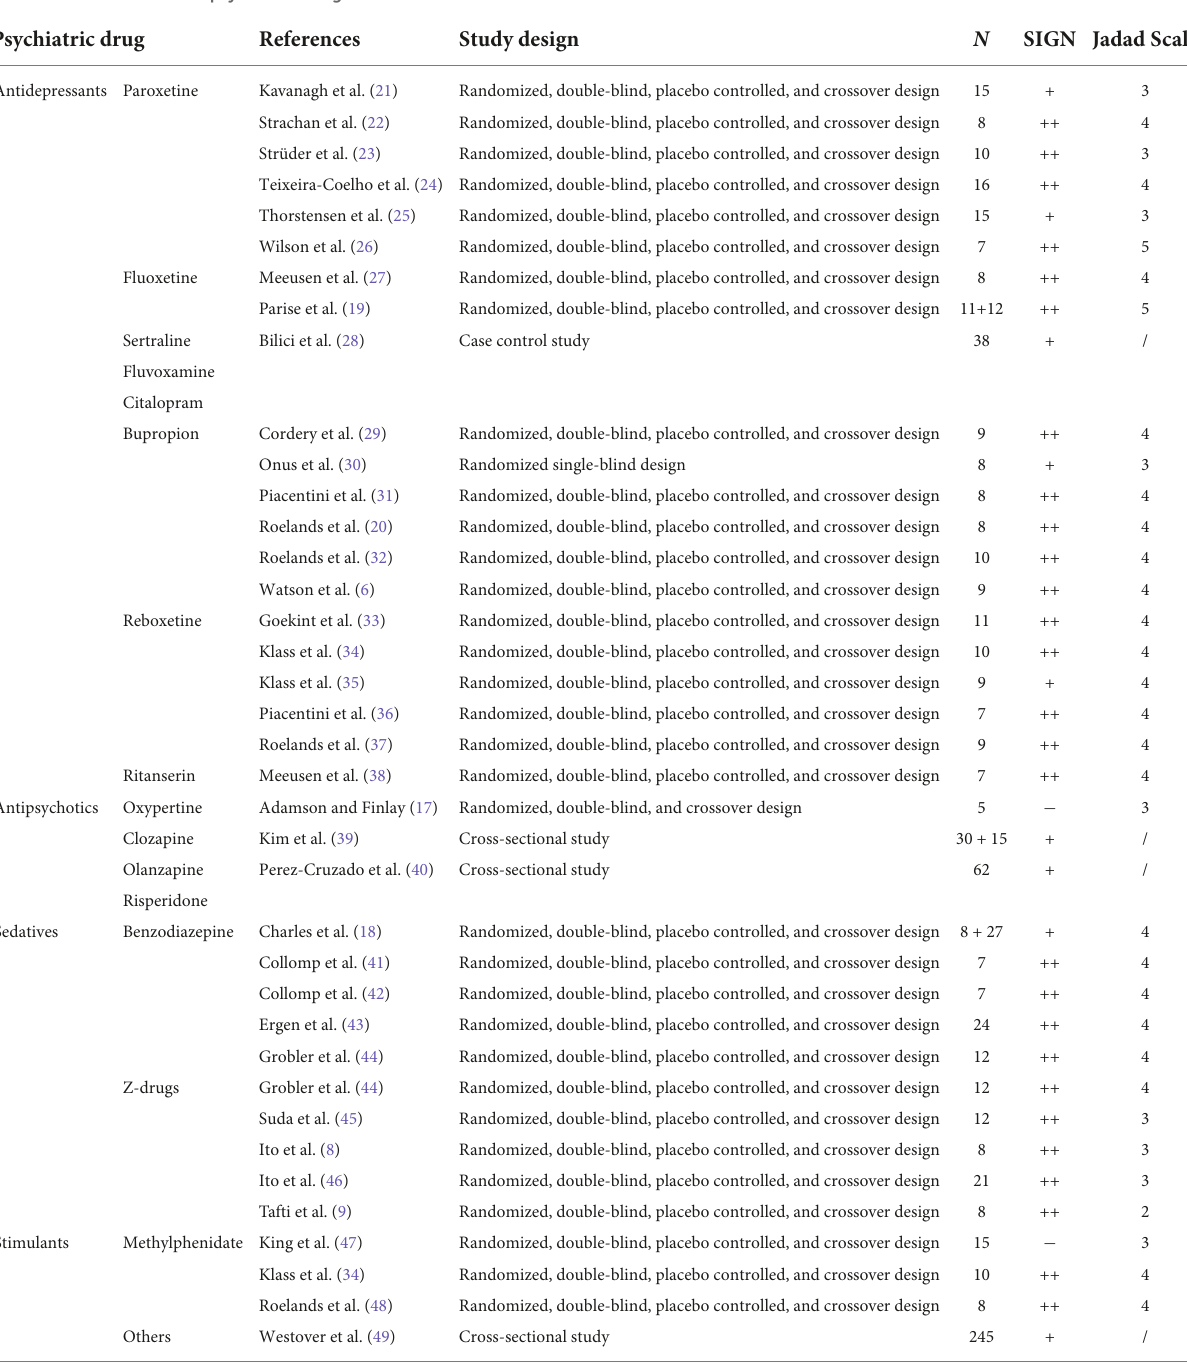
TABLE 1 List of evaluated psychiatric